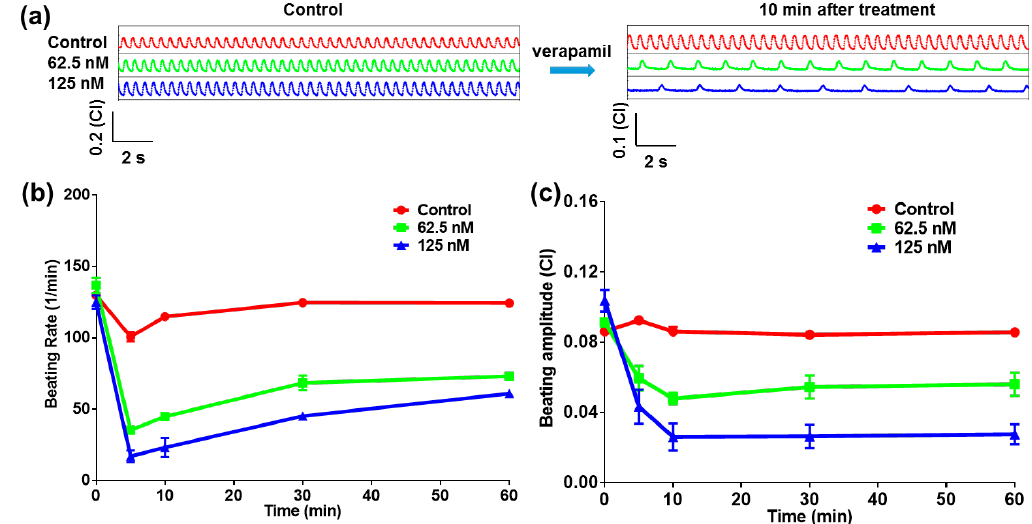
Figure 2. Heart-on-a-chip for verapamil test. ( a ) The beating signals before and after the verapamil with different concentrations are administered on the cardiomyocytes; ( b ) Statistical beating rate within 60 min in the presence of verapamil; ( c ) Statistical beating rate within 60 min in the presence of verapamil.